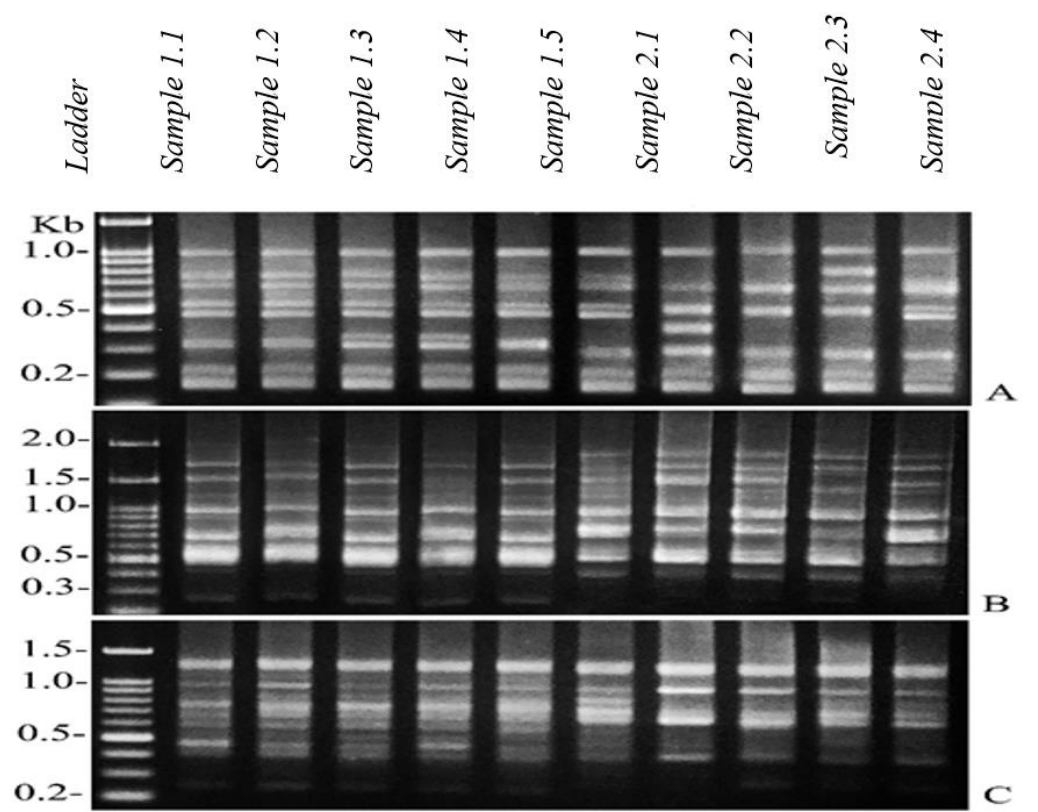
Figure 2. Examples of ISSR fingerprints from the reference catfish (1.1, 1.2, 1.3, 1.4 and 1.5) and the landfill catfish (2.1, 2.2, 2.3, 2.4 and 2.5) from the specific primers TGACCCCTCC. ( A ) GTAGACGAGC, ( B ) TGTCTGGGTG and ( C ) showing monomorphic bands.